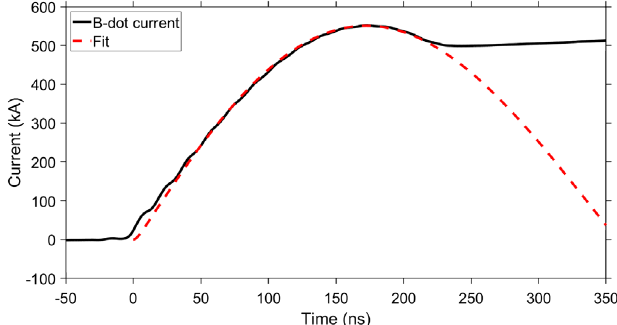
FIG. 5. Example of a current pulse with a 3.5 nH short-circuit ¼ (cid:1) 60 kV. The dashed line is a load, for a charge voltage V c least-squares fit to an RLC pulse with L ¼ 22 nH and R ¼ 21 m Ω .